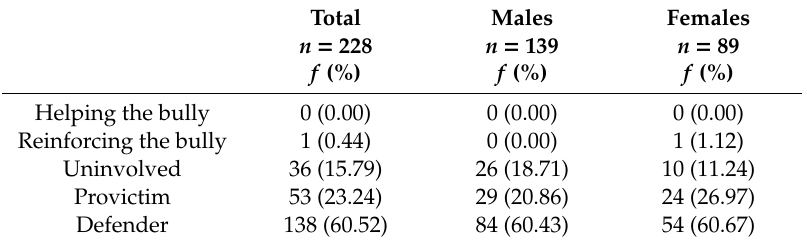
Table 2. Distribution of the bystander subroles for the total sample and for each sex.